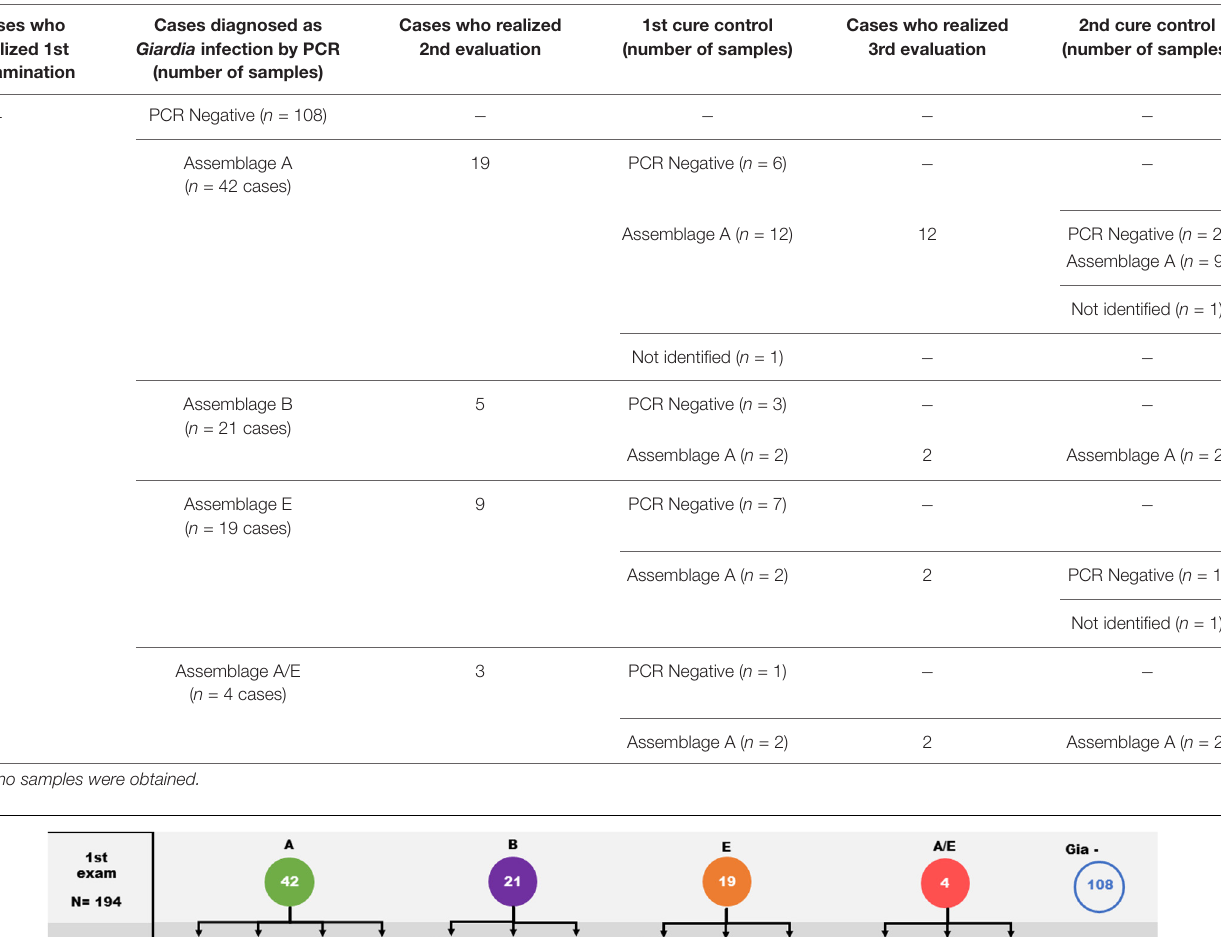
TABLE 1 | Giardia lamblia assemblages found at first diagnosis and after treatment.